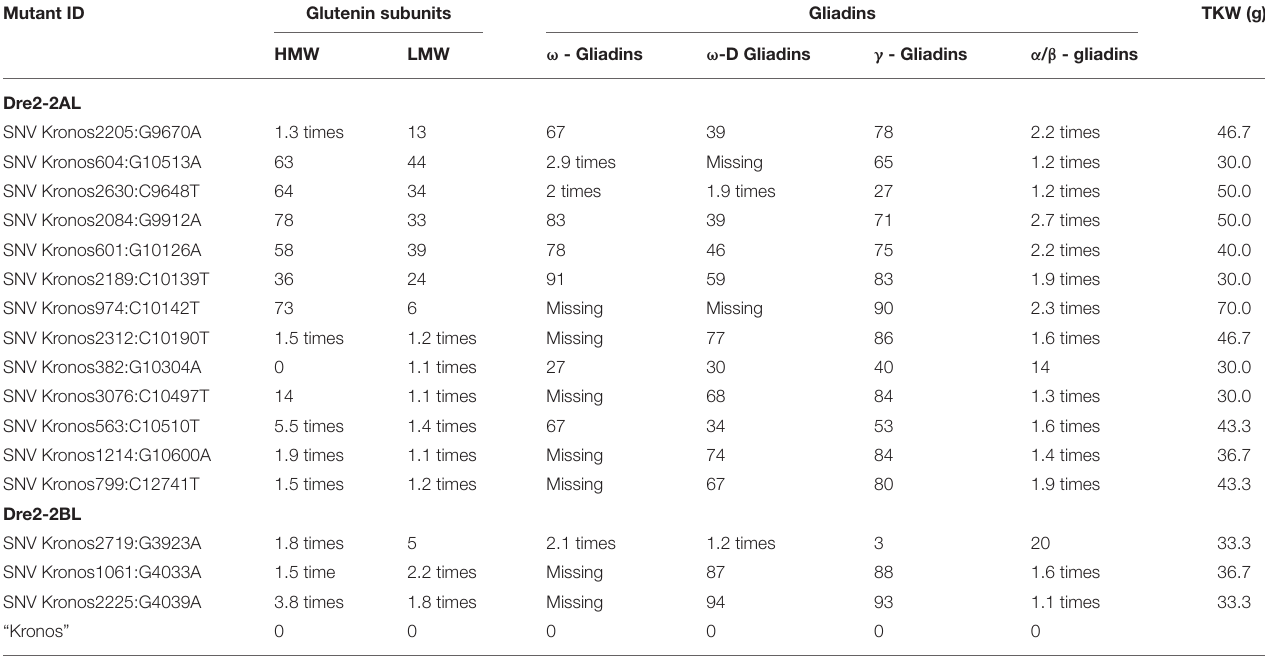
TABLE 3 | List of selected mutants in the wheat DRE2 genes showing reductions (in percent) or over accumulations in the content of various gluten proteins. Mutant ID Glutenin subunits Gliadins TKW (g) HMW LMW ω - Gliadins ω -D Gliadins γ - Gliadins α / β - gliadins